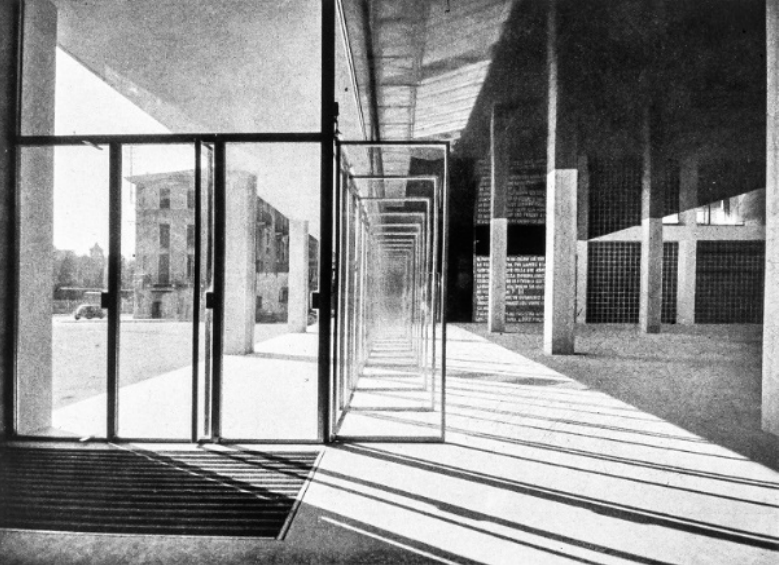
Figure 15. Casa del fascio by Giuseppe Terragni. Como (1932–1936). The entrance with the Securit glass doors. Photo from (Sartoris 1941, p. 395).